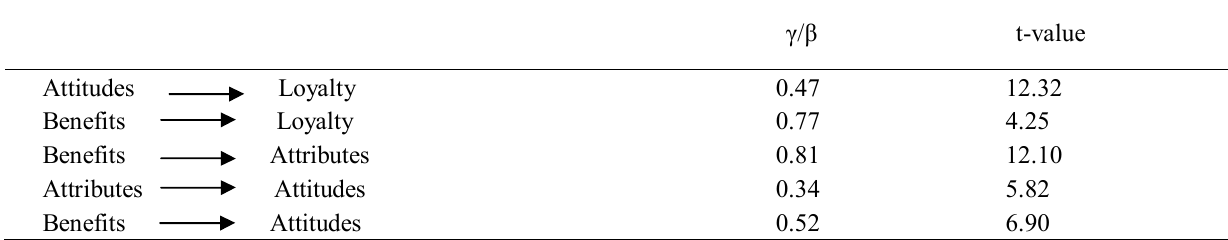
Table 3. Correlations: (Group number 1 - Default